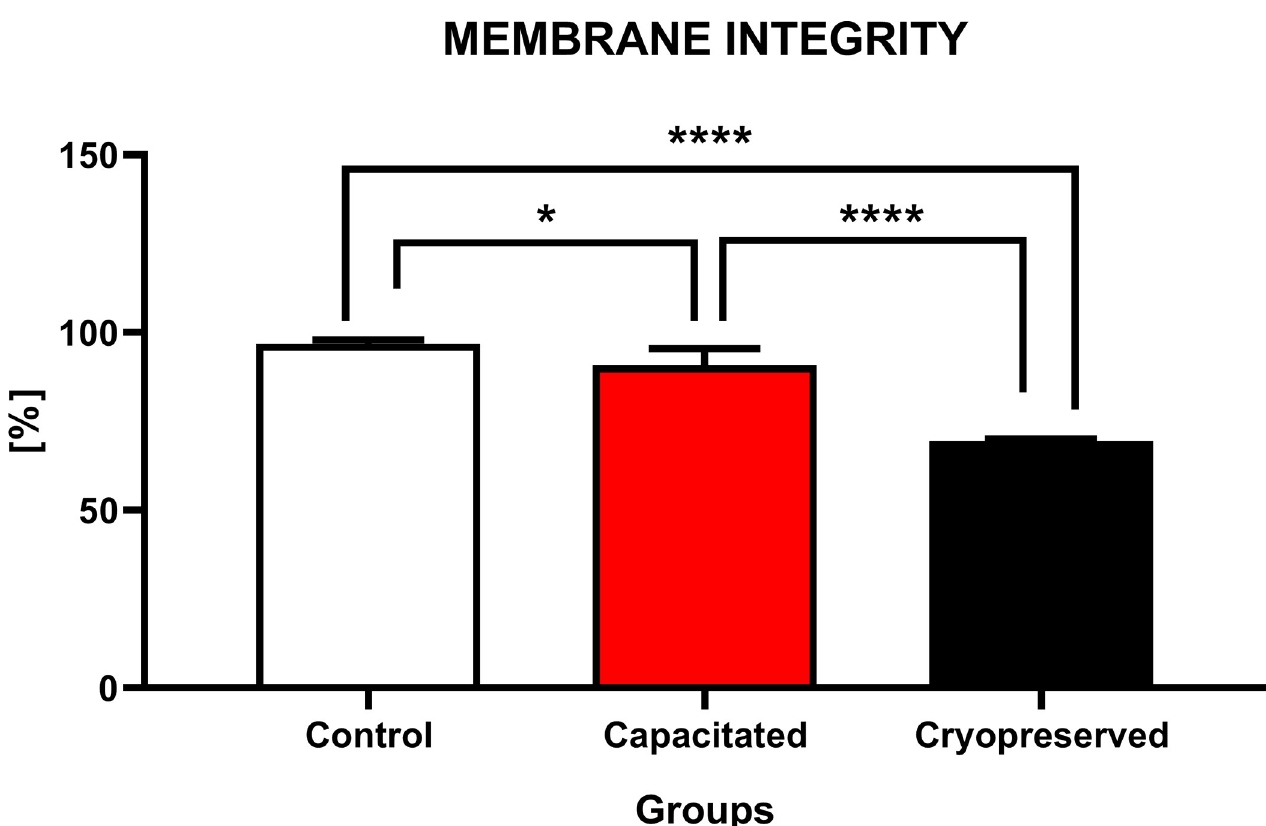
Fig 5. Membrane integrity of non-capacitated, in vitro capacitated and cryopreserved bovine spermatozoa. Each column showed the percentage of cells with intact cell membrane between the groups ( ± SD). The level of significance was set at � P < 0.05; �� P < 0.01; ��� P < 0.001; ���� P < 0.0001.